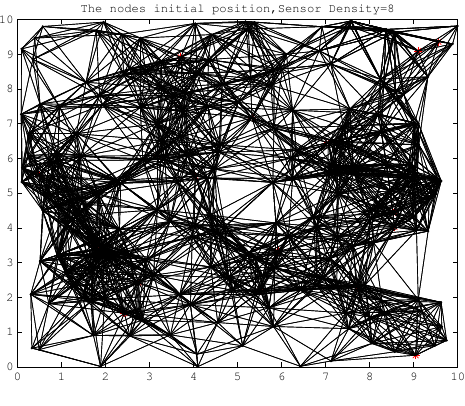
Figure 2. Random uniform